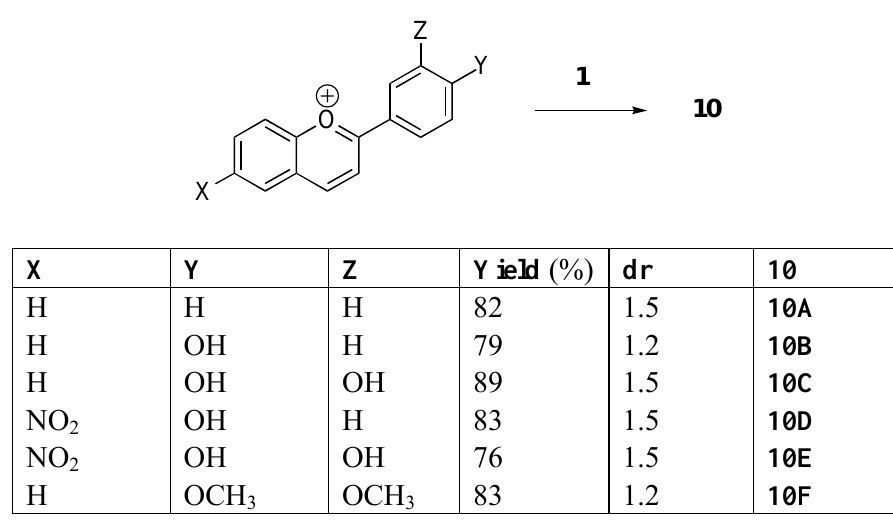
Table 1 . Reactions of 1 with Benzopyrilium